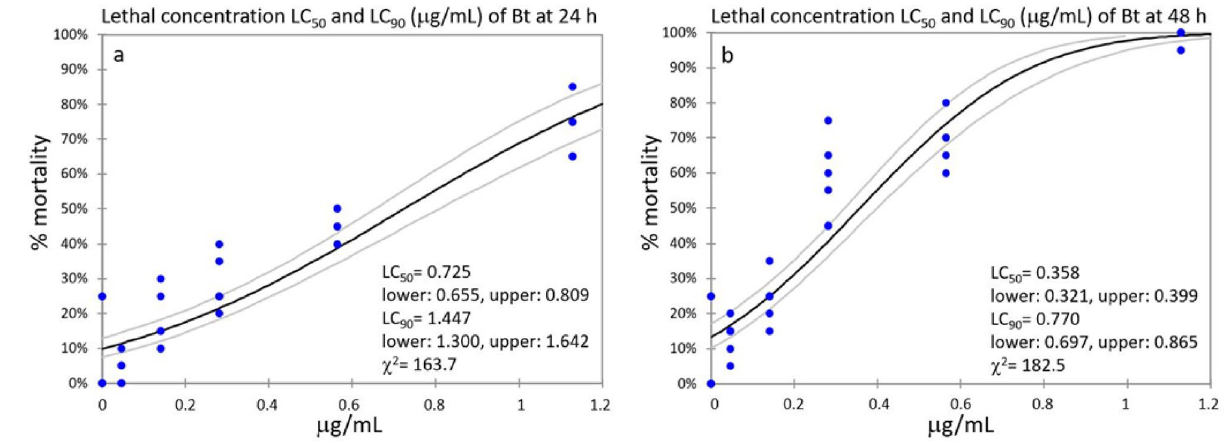
Figure 2. Bt lethal concentrations (LC 50 and LC 90 ), at 24 h ( a ) and 48 h ( b ), were calculated by Probit analysis with 95% confidence